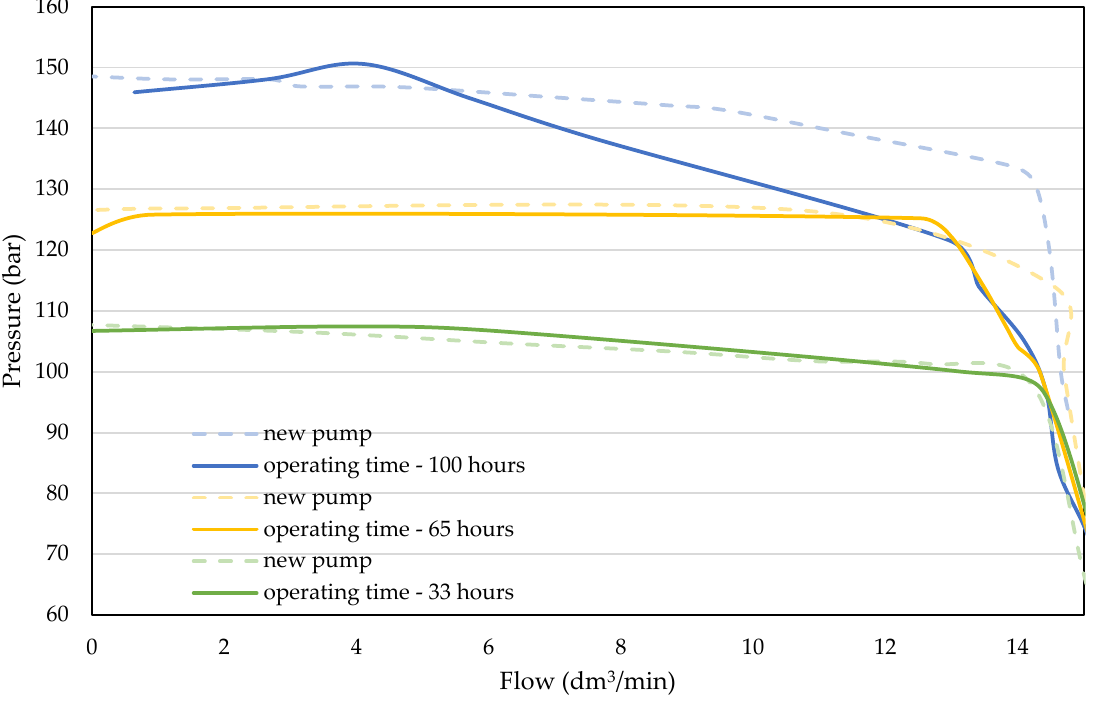
Figure 10. The pump characteristics. The measured curves for 100 and 125 bar are consistent with the new pump ones.